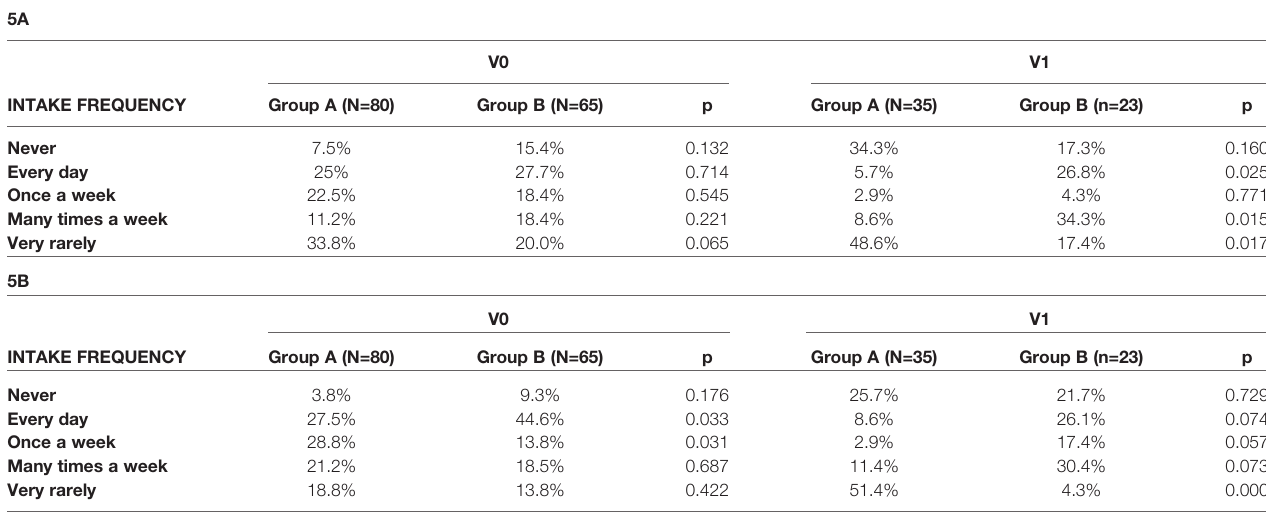
TABLE 5 | Between-group comparison analysis regarding sugar-sweetened beverage (5A) and snack (5B) intake between baseline (V0) and 12-month evaluation (V1). 5A V0 V1